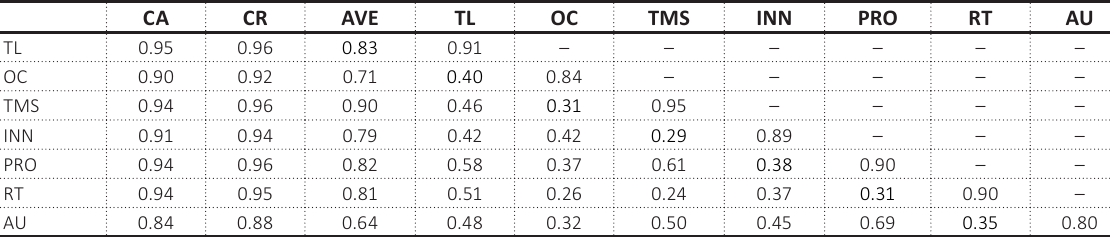
Table 3. Results of the measurement